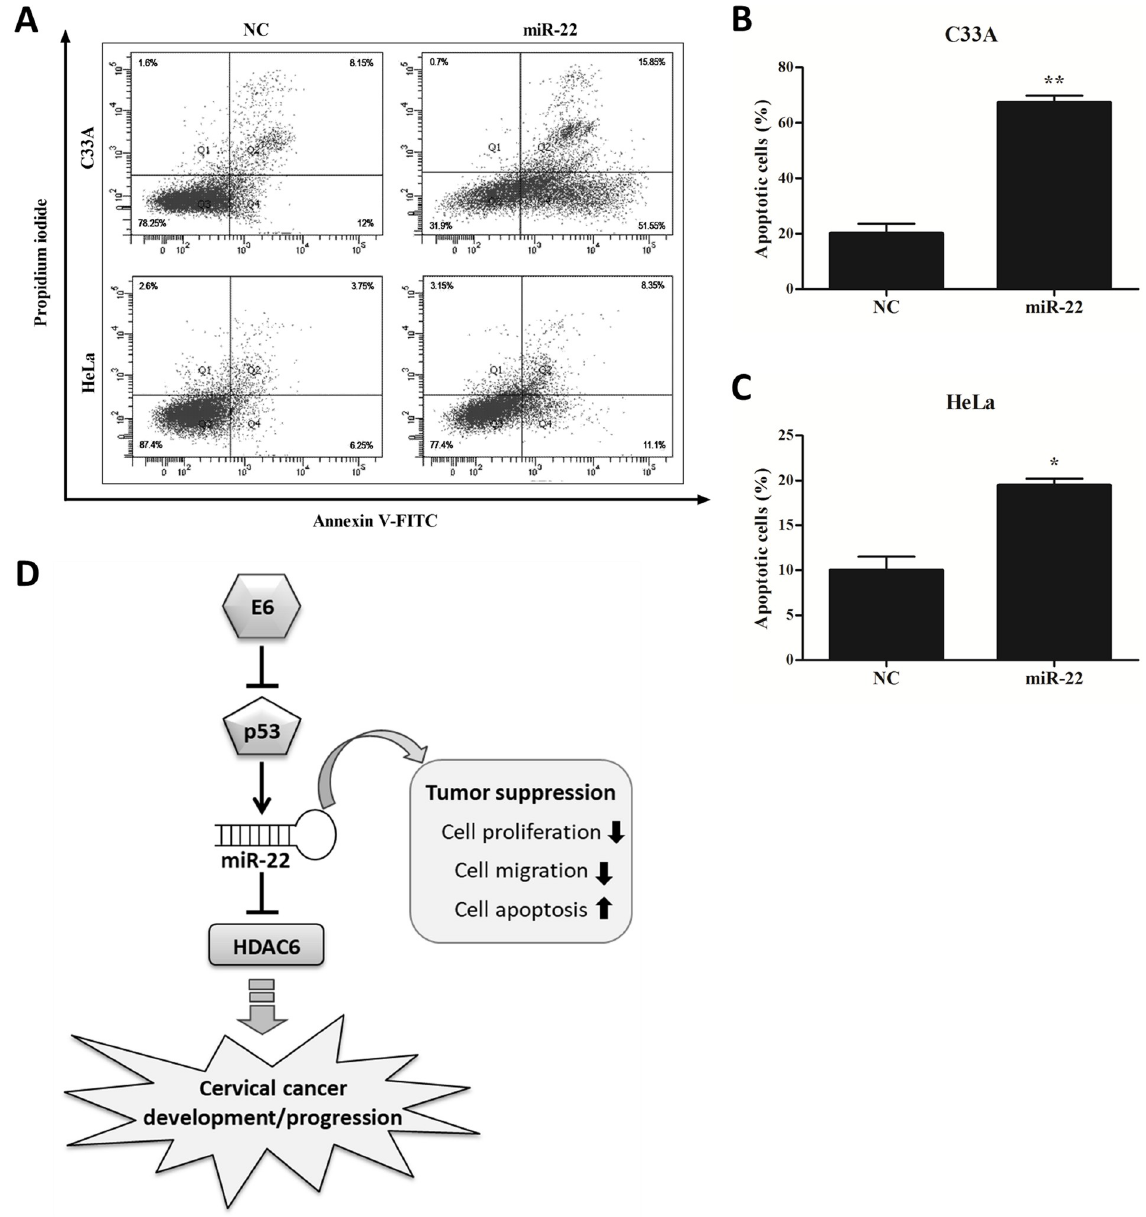
Fig 6. miR-22 induced cervical cancer cells apoptosis. Flow cytometric assay showed the increased fractions of apoptotic cells in C33A and HeLa cell lines transfected with miR-22 ( A ). Mean fraction of apoptosis in C33A ( B ) and HeLa ( C ) cells. The values represent apoptotic cells. Error bars indicate the standard error of the mean (SEM) of triplicated independent experiments. � P < 0.05, �� P < 0.01. D. Hypothetical mechanism by which HPV E6 induces cervical cancer development/progression through the p53/miR-22/HDAC6 pathway. Modulation of tumor suppressor miR-22 and its down-stream target HDAC6 by the HPV E6/p53 pathway is involved in the development process of cervical